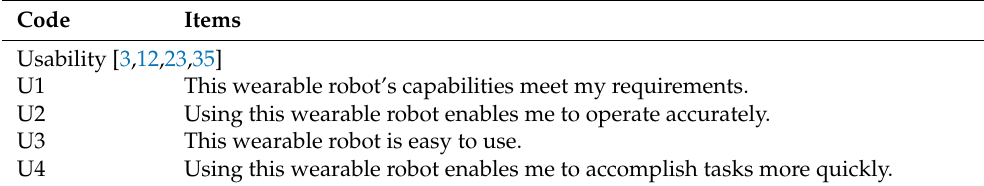
Table 1. Measurement properties of